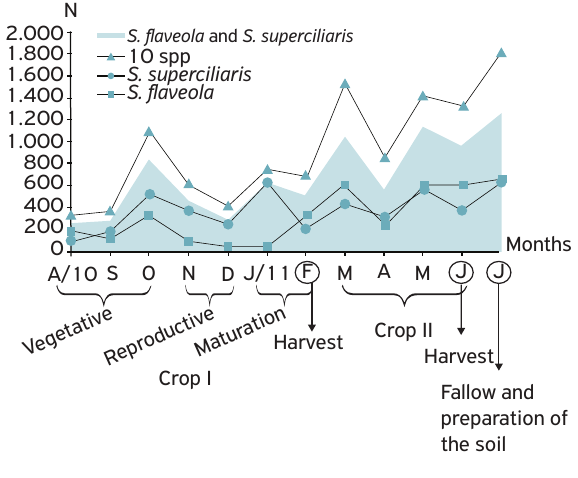
Figure 4. Annual (August to July) abundance of S. superciliaris and S. fl aveola in relation of the other species of granivorous